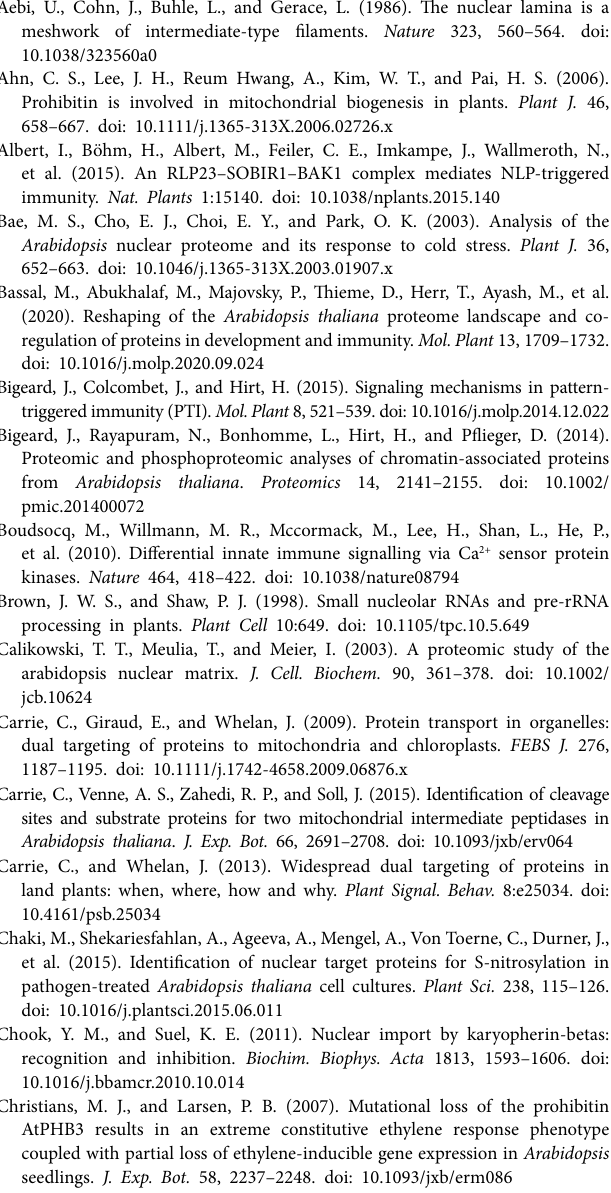
Supplementary Figure 1 | Non-cropped western blot of nuclear and cellular proteins with anti-Histone H3 antibody. Two independent experiments are shown, N denotes nuclear and C